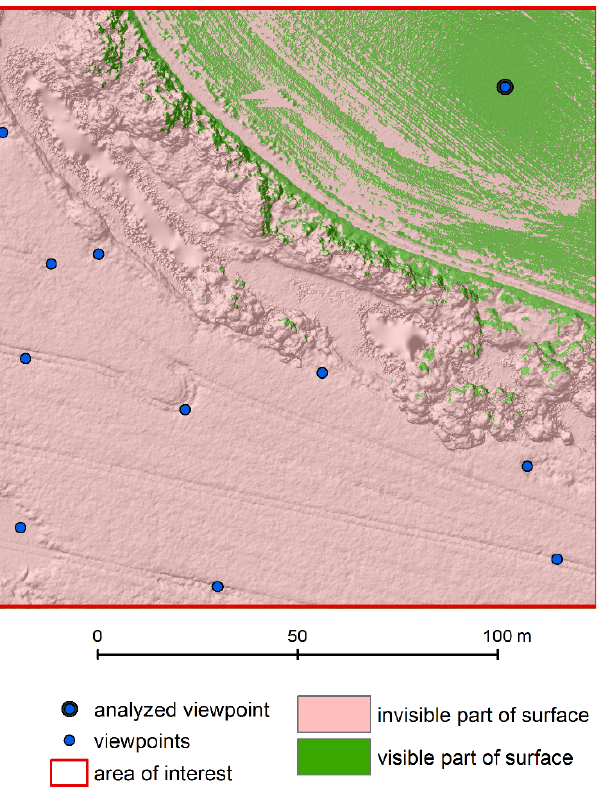
Figure 3. Visibility from point north of the river.